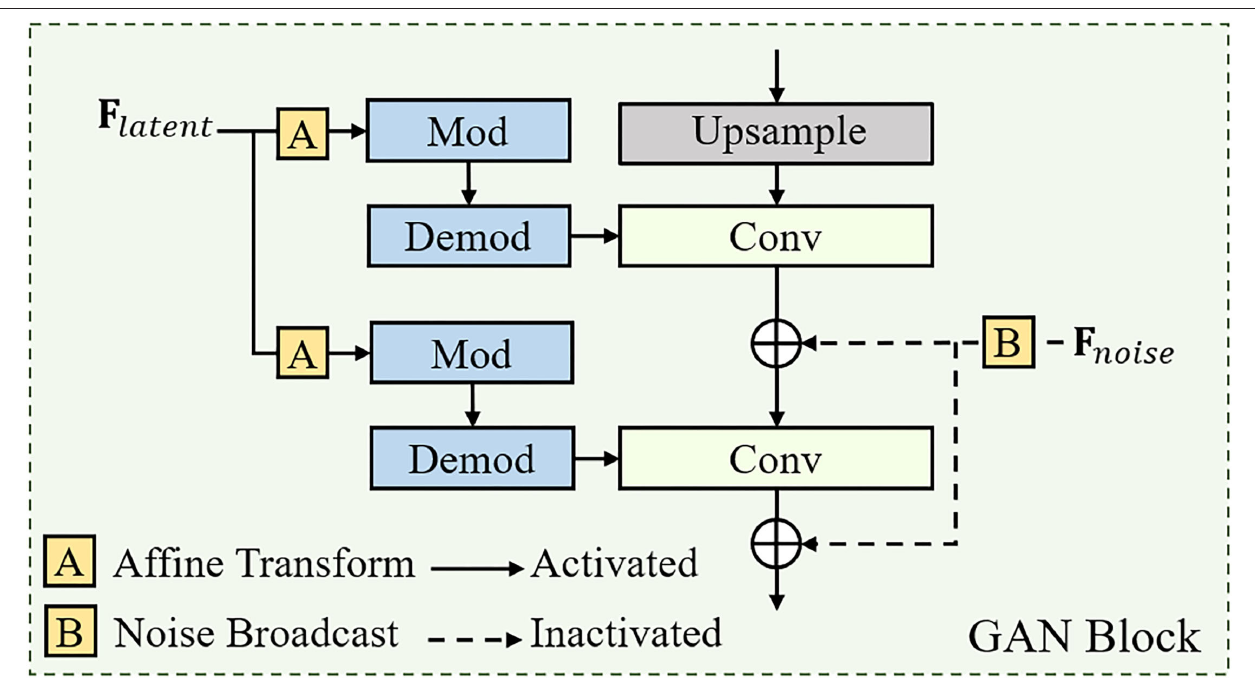
FIGURE 4 | The detailed structures of the adaptive prior feature fusion (APFF) block. The cascading residual channel attention blocks (RCABs) (Zhang et al., 2018c) can make the feature extraction focus on more informative components of the LQ